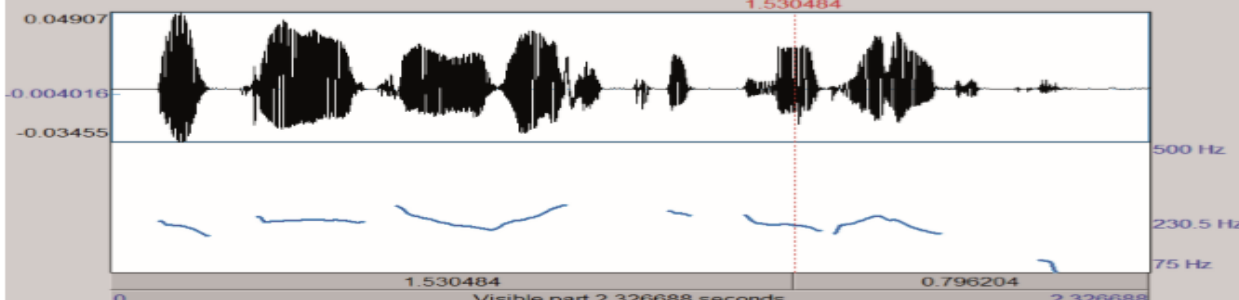
Fig.5 Pitch contour for Boredom